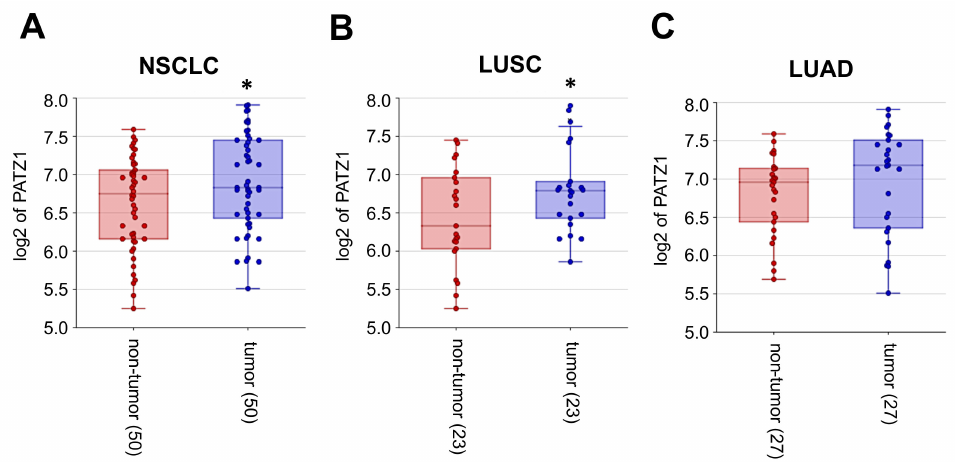
Figure 2. PATZ1 is overexpressed in tumor vs. non-tumor NSCLC samples. ( A ) A gene